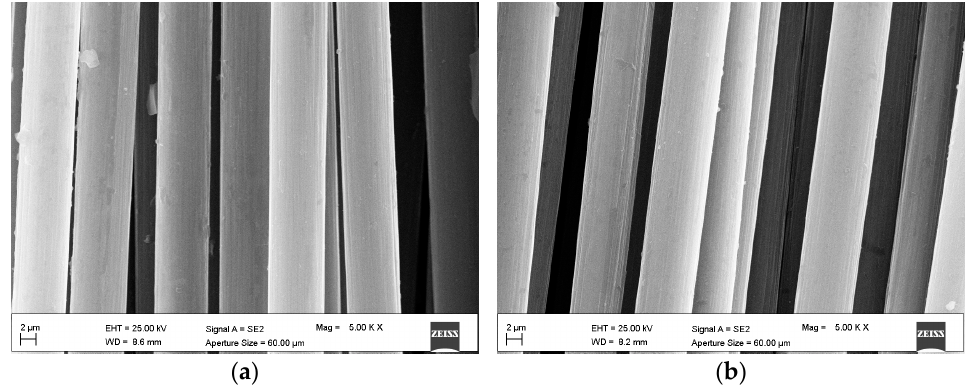
Figure 9 . SEM images of ( a ) C-Dry, and ( b ) C-Ox multifilament yarns. Magnification 5.00 Kx.